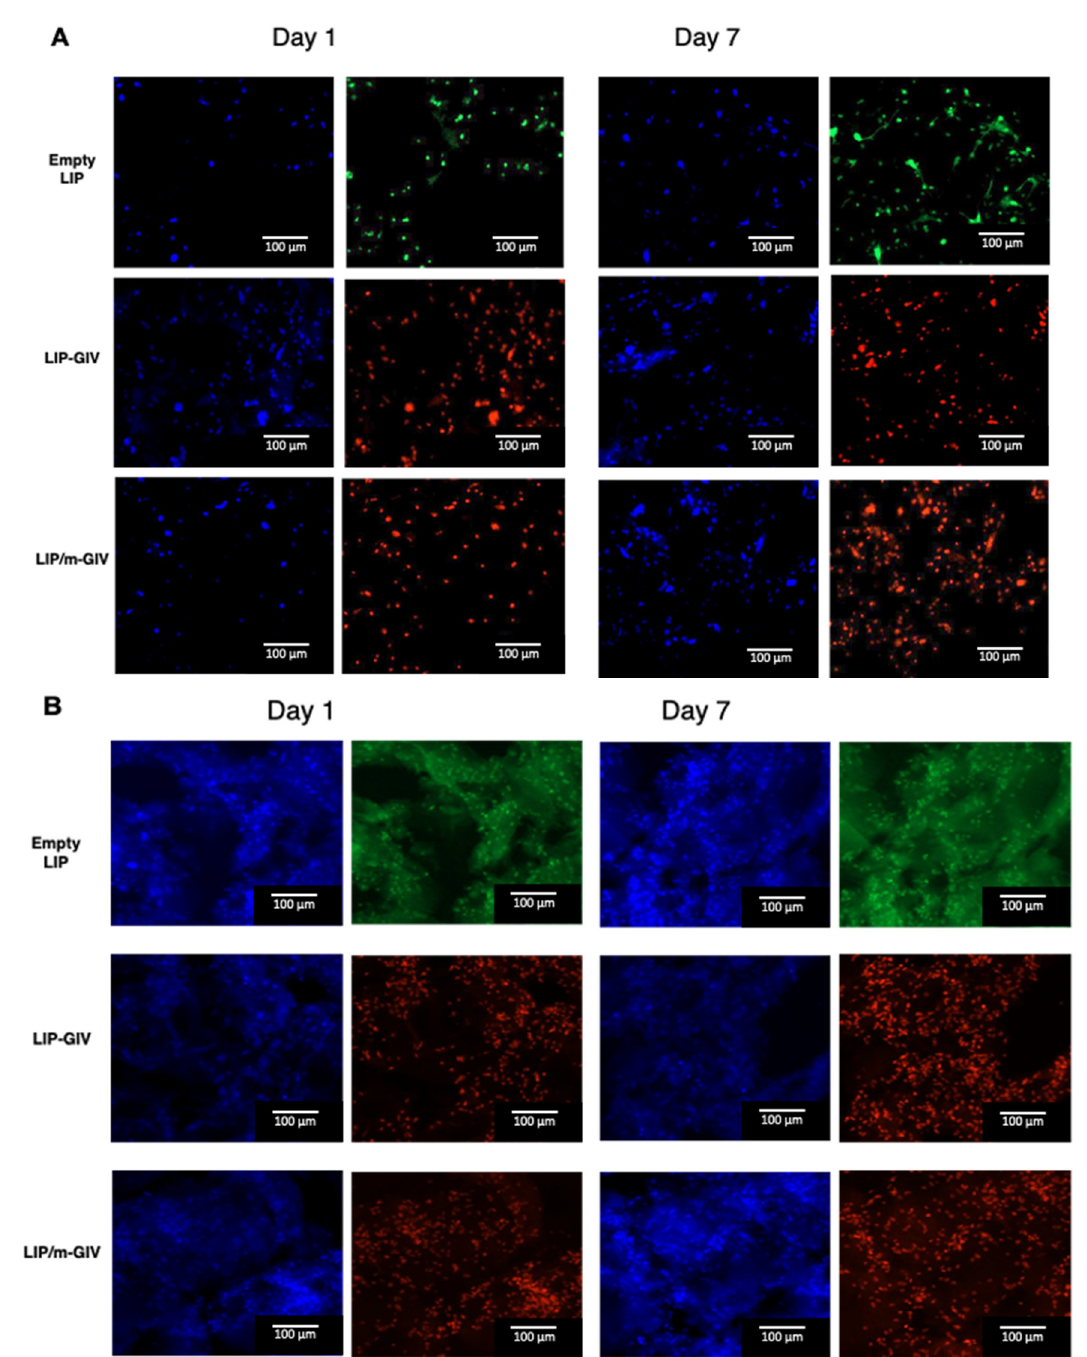
Figure 7. LIVE/DEAD microscopy images on day 1 and 7 after printing. U87 ‐ MG ( A ) or Gli36 Δ EGFR ‐ 2 ( B ) cell lines were bioprinted with gelatin ‐ chitosan hydrogel and cultured for 1 and 7 days. Then, empty liposomes, LIP ‐ GIV, or LIP/m ‐ GIV were administered for 24 h. Blue, DAPI (nuclei); red, EthD (dead cells); green, calcein (living cells). Cell viability was calculated as ((number of green ‐ red stained cells/number of total cells) × 100) using Fiji ImageJ software. Table 2. Cell mortality (% of control ± SD) in 3D ‐ bioprinted models after treatment with LIP ‐ GIV or LIP/m ‐ GIV.